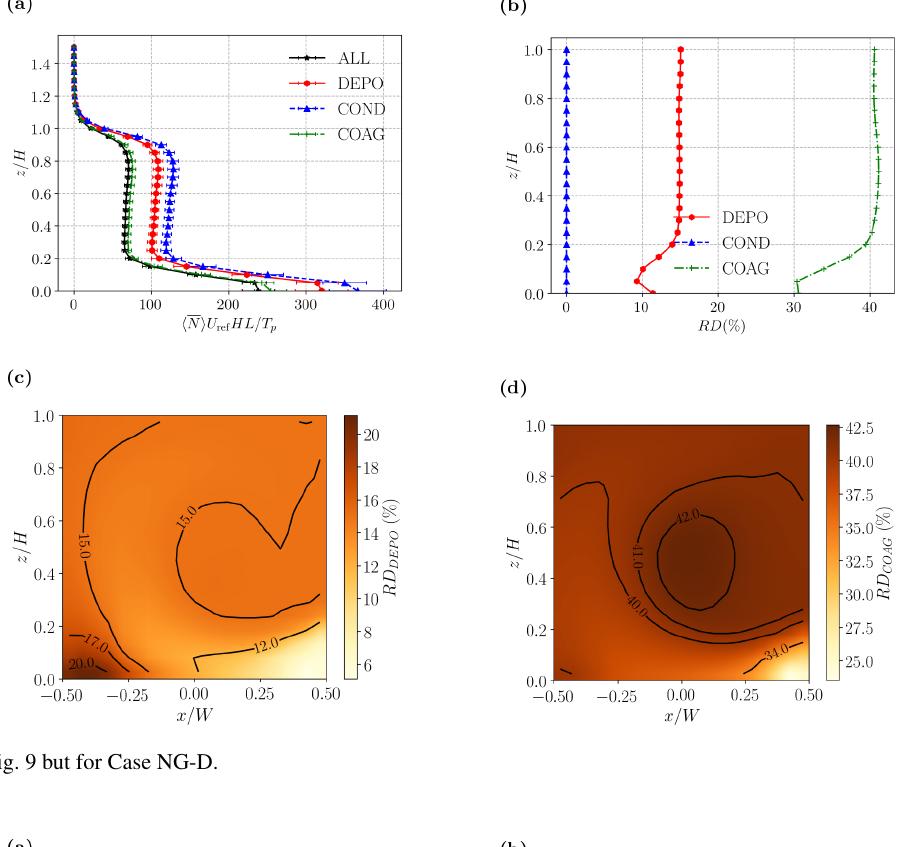
Figure 10. As in Fig. 9 but for Case NG-D.